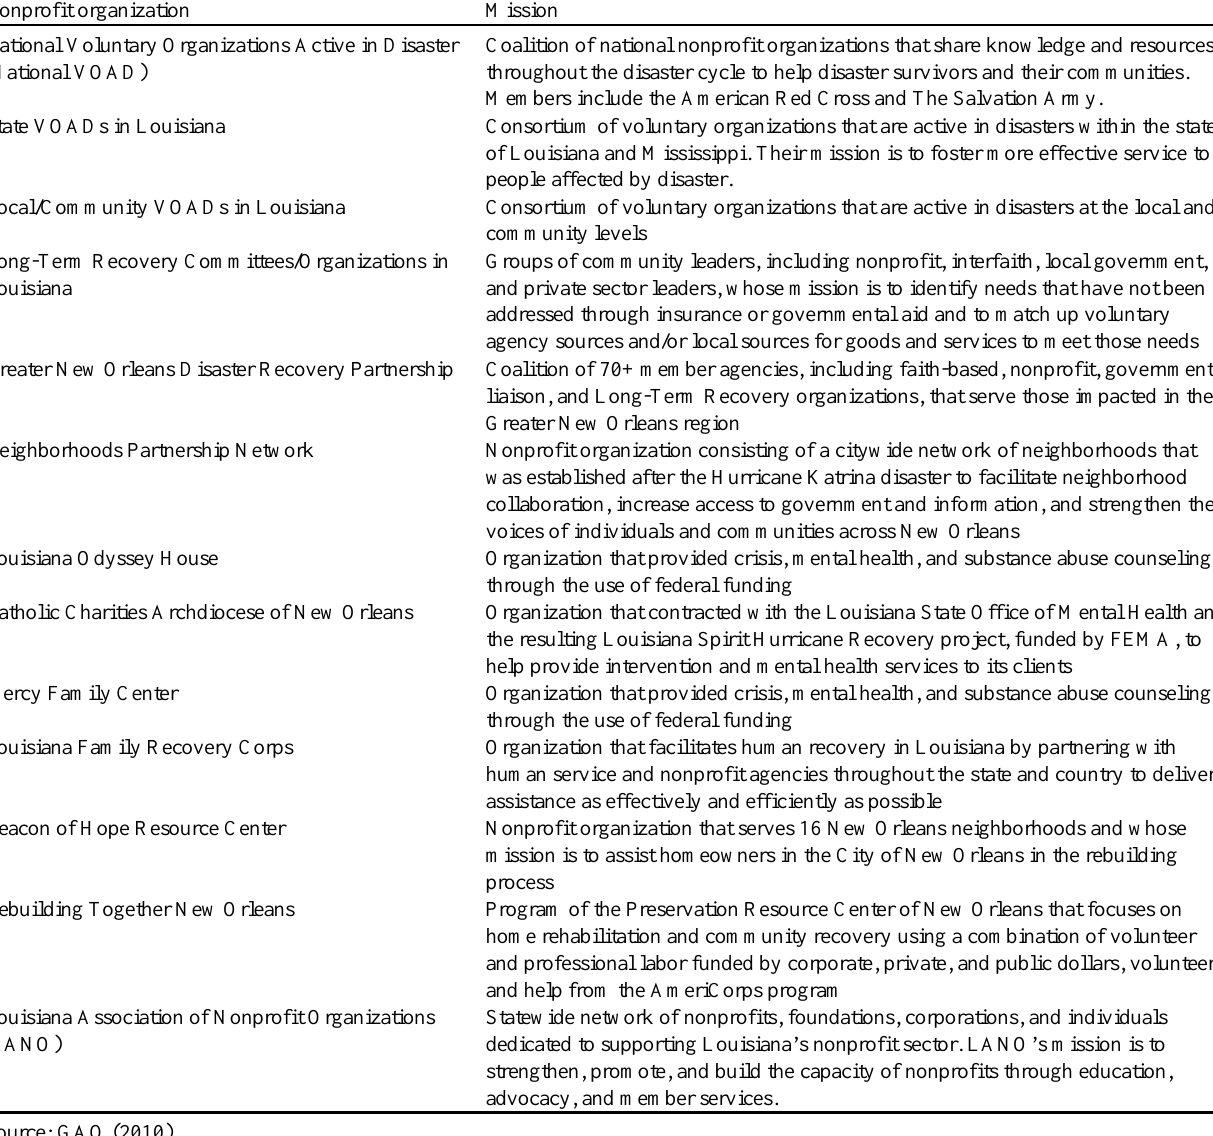
Table 3 . Nonprofit organizations involved in post-Katrina rebuilding in New